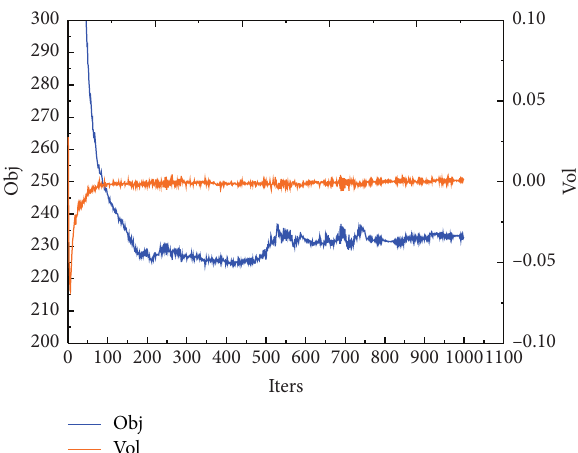
Figure 15: Convergence history of the MBB example with the QVT method.